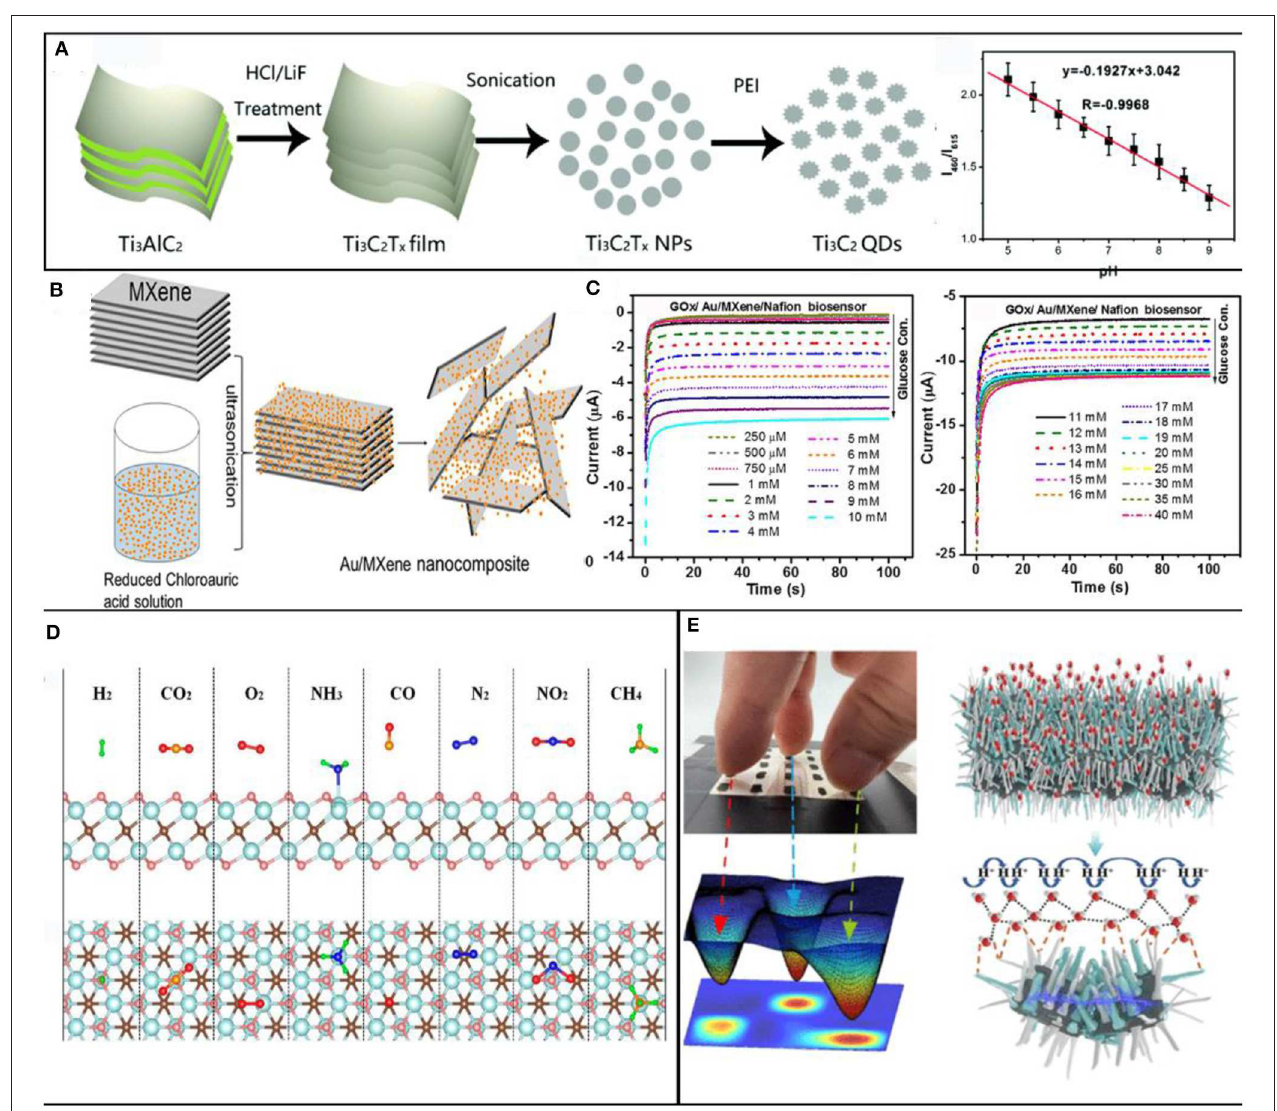
FIGURE 5 | MXenes for biosensor. (A) Schematic illustrations for preparing the Ti 3 C 2 QDs by using a liquid exfoliation and solvothermal treatment approach; reproduced from Chen et al. (2018) with permission from The Royal Society of Chemistry. (B) Schematic showing the synthesis process of Au/MXene nanocomposites; (C) GOx/Au/MXene/Nafion/GCE at a constant voltage of − 0.402V; reproduced from Rakhi et al. (2016). (D) Application of MXenes for detection of NH 3 . (D) is reproduced from Yu et al. (2015) with permission from American Chemical Society. (E) Schematic of the adsorption process of water molecules at the Ti 3 C 2 /TiO 2 composite film. Reproduced from Li N. et al. (2019) with permission from American Chemical